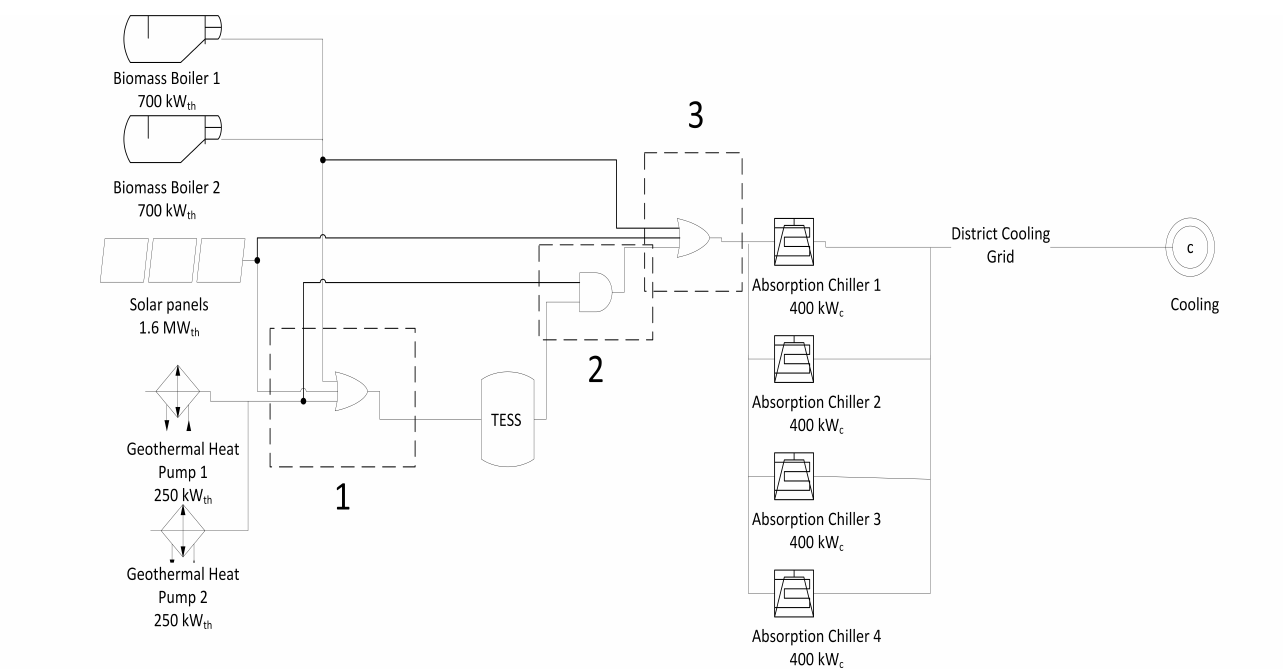
Figure 12. Final P-graph representing the proposed superstructure of the system for the cooling scenario.